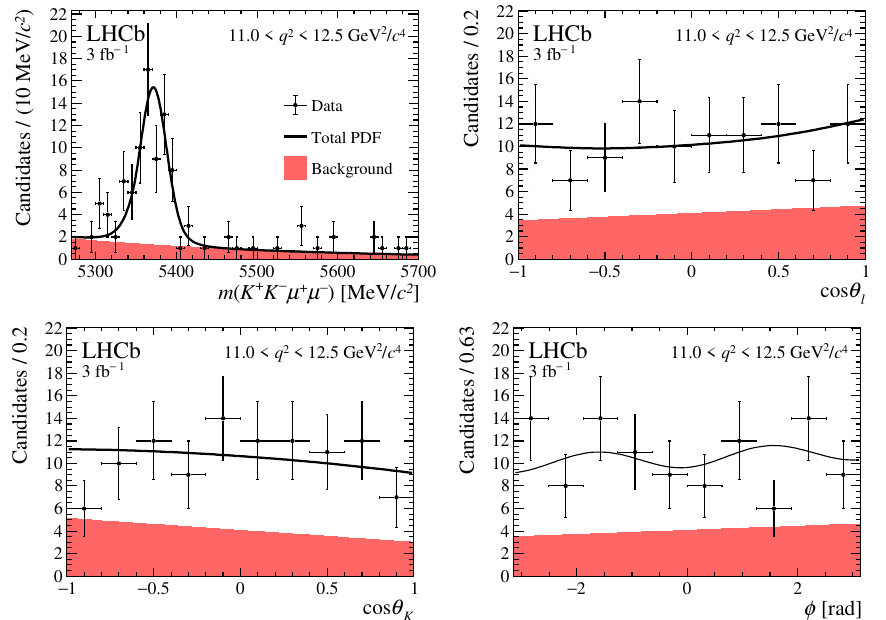
Figure 24 . Mass and angular distributions of B 0 11 . 0 < q 2 < 12 . 5 GeV 2 /c 4 for data taken in 2011–2012. The data are overlaid with the projec- tions of the fitted PDF.